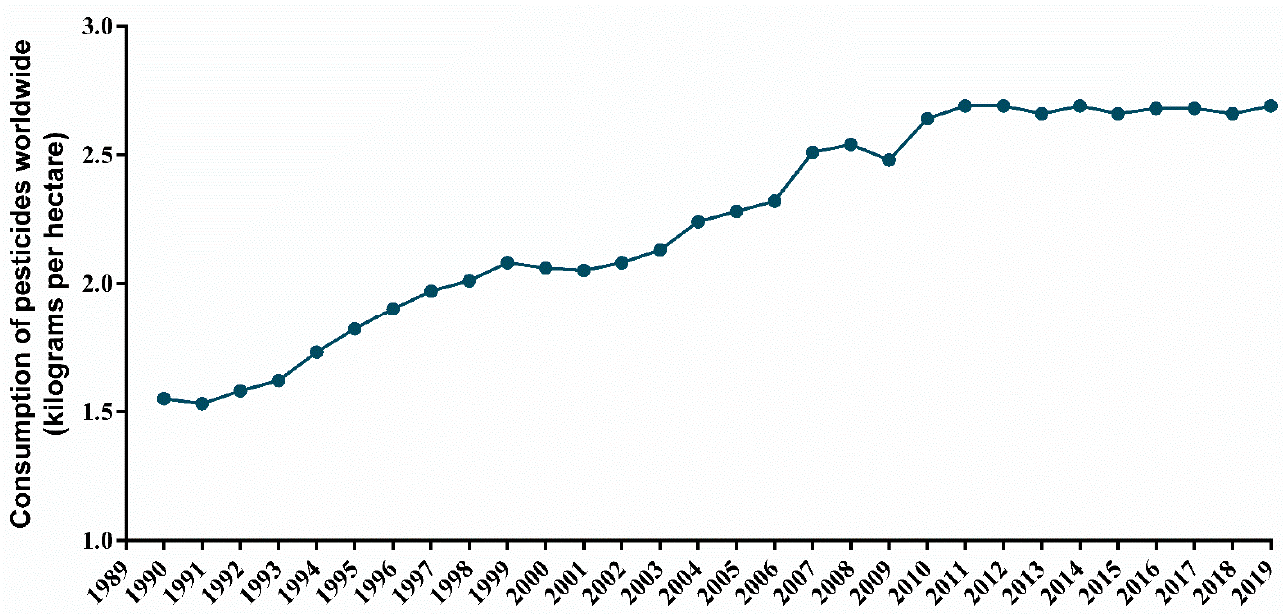
Figure 4. Kilograms of pesticides used by hectares of crops worldwide over the years, according to Food and Agriculture Organization of the United Nations.